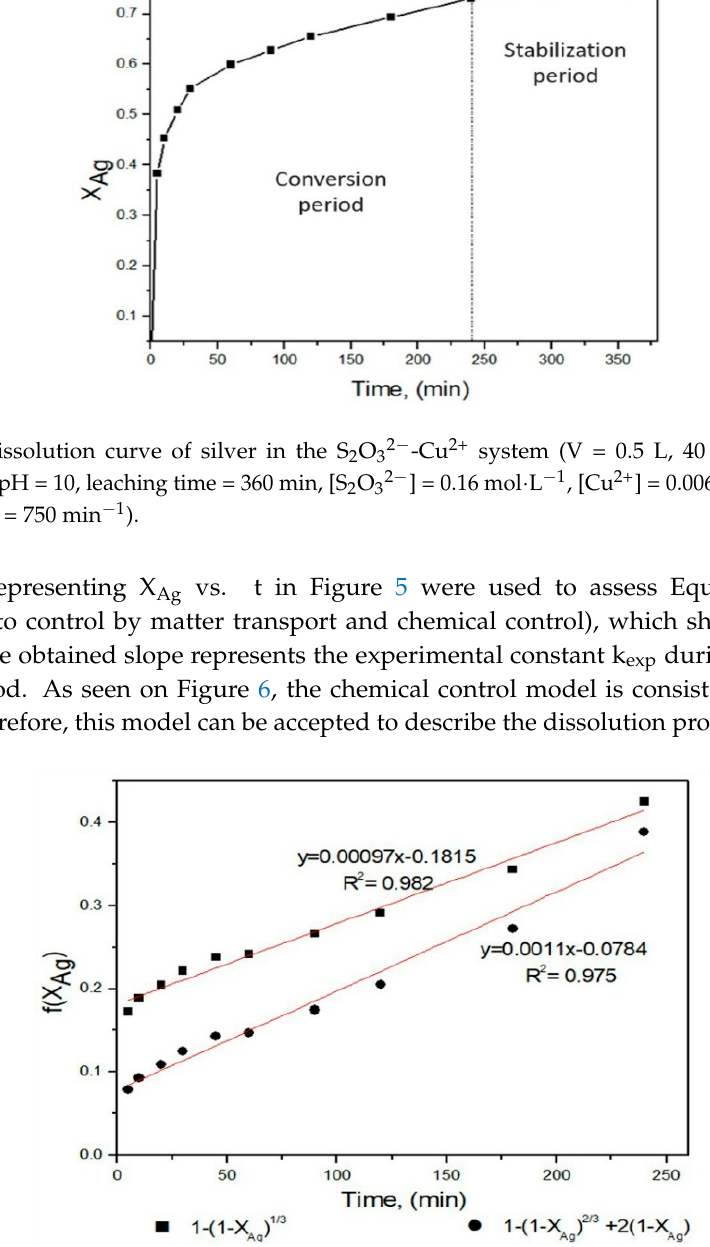
Figure 7. Effect of partial pressure of oxygen on the leaching reaction of silver (V = 0.5 L, 40g L − 1 Mineral, pH = 10, leaching time = 240 min, [S 2 O 32 − ] = 0.16 mol L − 1 , [Cu 2+ ] = 0.006 mol L − 1 , 298 K (25 °C), RPM = 750 min − 1 ). 3.4.2. Particle Size Effect For the kinetic study of the leaching of silver in the proposed medium, we assessed the following effects on the dissolution rate of Ag: d 0 , [Cu 2+ ], [S 2 O 32 − ], [OH − ], T, RPM and PO 2 . In order to determine the effect of the initial particle size, we conducted a series of experiments where the initial particle size was varied, while the other variables were kept constant. According to Equation (4) corresponding to the shrinking core model with chemical control, the constant k exp is defined as follows: